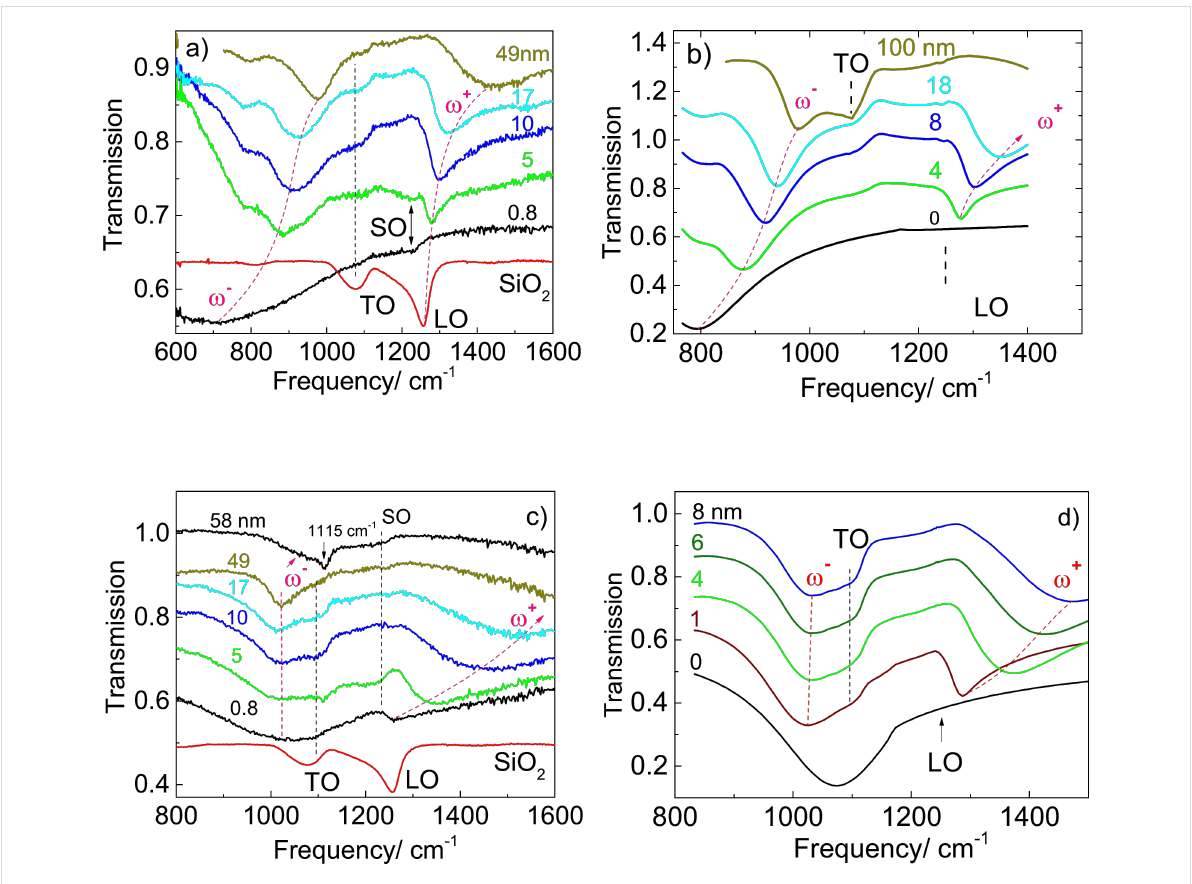
Figure 6: Experimental (a,c) and calculated (b,d) IR transmission spectra of nanoantenna array with the lengths of 1900 nm (a,b) and 1400 nm (c,d) fabricated on SiO 2 layers of different thicknesses measured at normal incidence. The IR transmission spectrum of a 49 nm thick SiO 2 layer on a Si substrate measured at off-normal (70°) incidence is shown for comparison. The vertical dashed lines indicate the frequency position of the TO, SO, and LO phonons in SiO 2